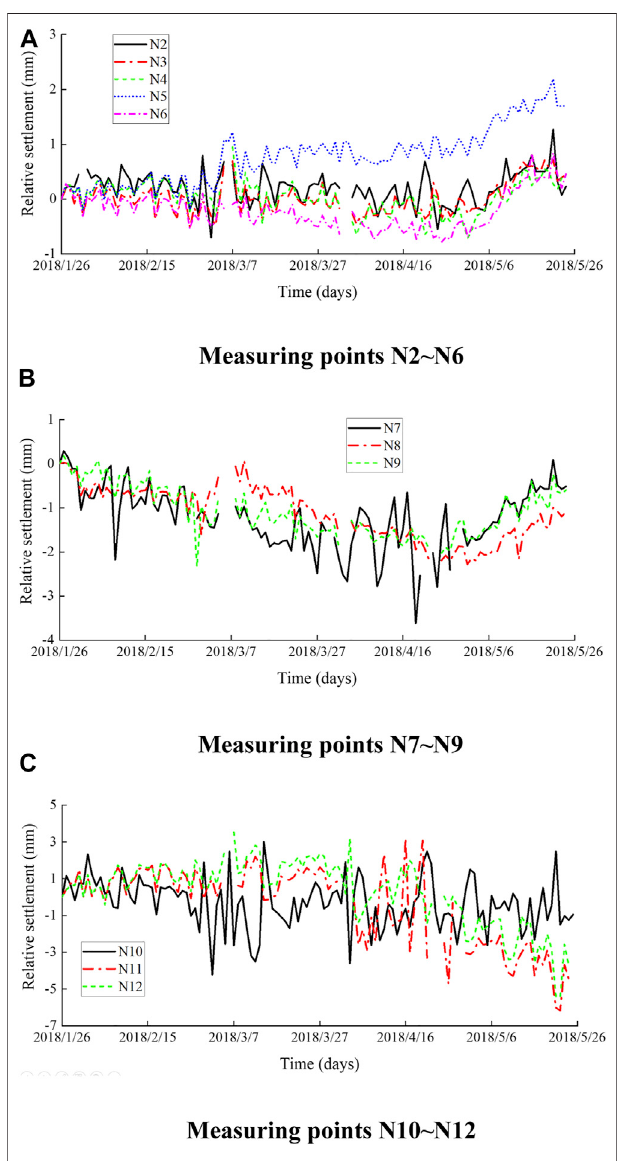
FIGURE6| Modi fi edrelativesettlementat themonitoringpointof (A) N2 to N6; (B) N7 to N9; and (C) N10 to N12.